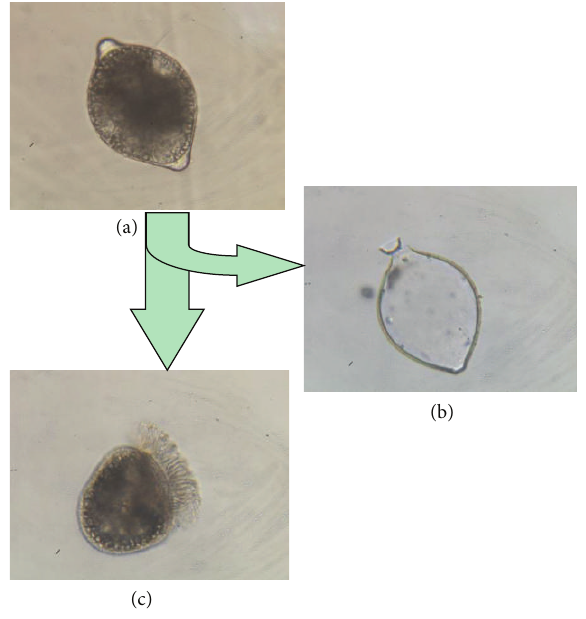
Figure 2: Photographs of Ciliophora cyst, with two opposite papulae (a). Its empty shell (hatch occurs from one of two papulae) (b). Germinated active stage, Strombidium ciliate (c).